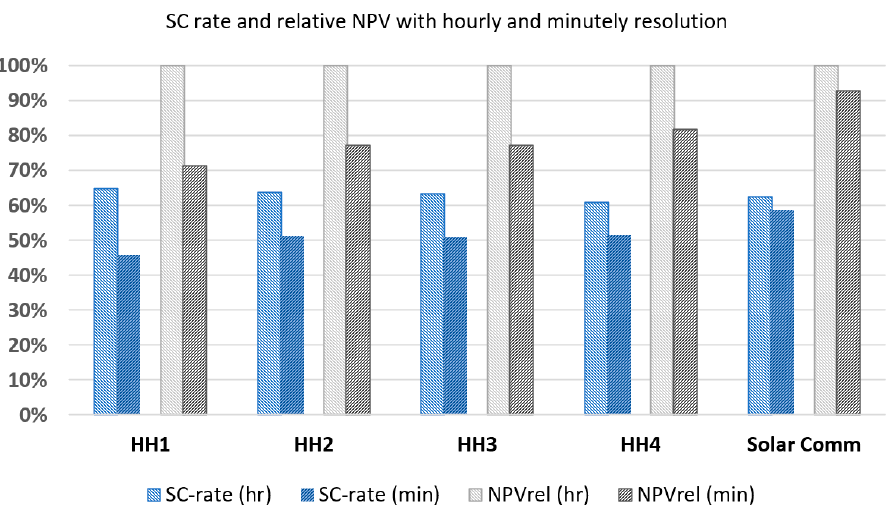
Figure 2. Self consumption rate (SC-rate) and net present value (NPV) for the four households individually (HH1–HH4) and as solar community (Solar Comm), both with houly (hr) and minute by minute (min) time resolution. The overestimation of both SC-rate and NPV when applying hourly time resolution is evident, with the actual benefit (darker columns) being between 18% and 29% lower than estimated based on hourly values. For the solar community, the discrepancy is noteworthily lower than for the individual households.